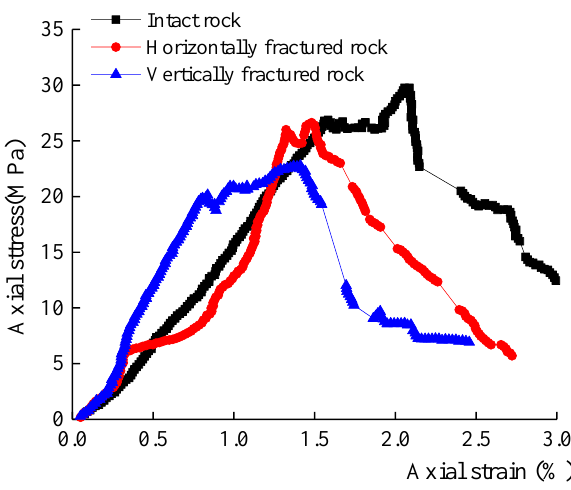
Figure 14. Stress–strain curve of siltstone specimens.